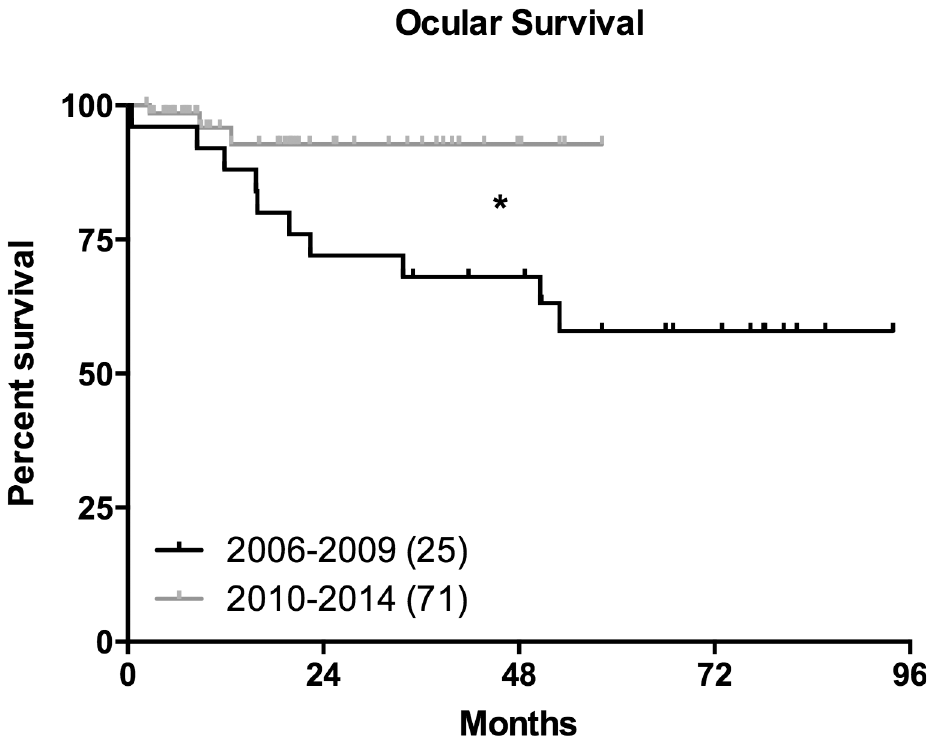
Fig 3. Ocular survival in unilateral advanced eyes treated with OAC. Ocular survival Kaplan-Meier curves for 96 patients, who had been treated with OAC. Patients were divided according to treatment period, 2006 – 2009 (black) and 2010 – 2014 (grey). The number of eyes in each group are depicted in the legend, * depicts a significant change; Mantel Cox test p value =